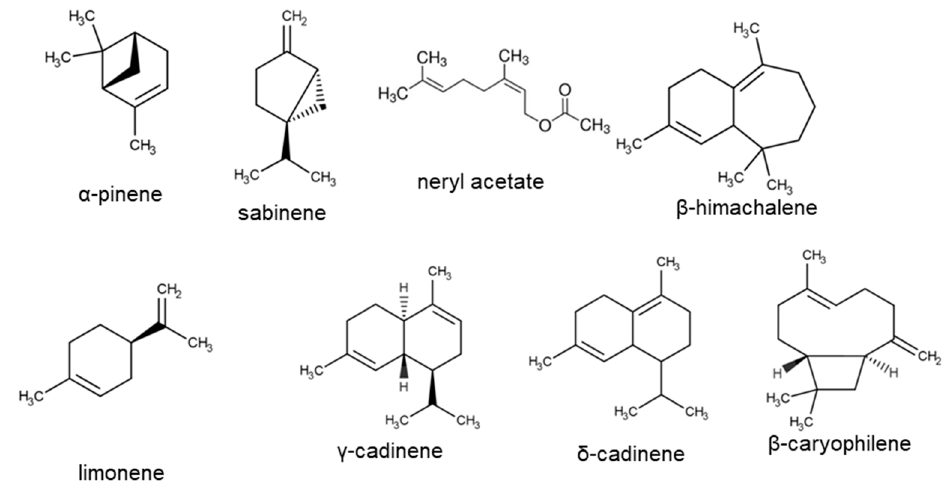
Figure 1. Structural formulas of the main compounds of Helichrysum arenarium and H. italicum . Table 4. Overall mean H. arenarium concentration (%) of sabinene, D-limonene, trans-verbenol, n- tetradecane and β -gurjunene where there was no significant difference among the three collections. Constituent